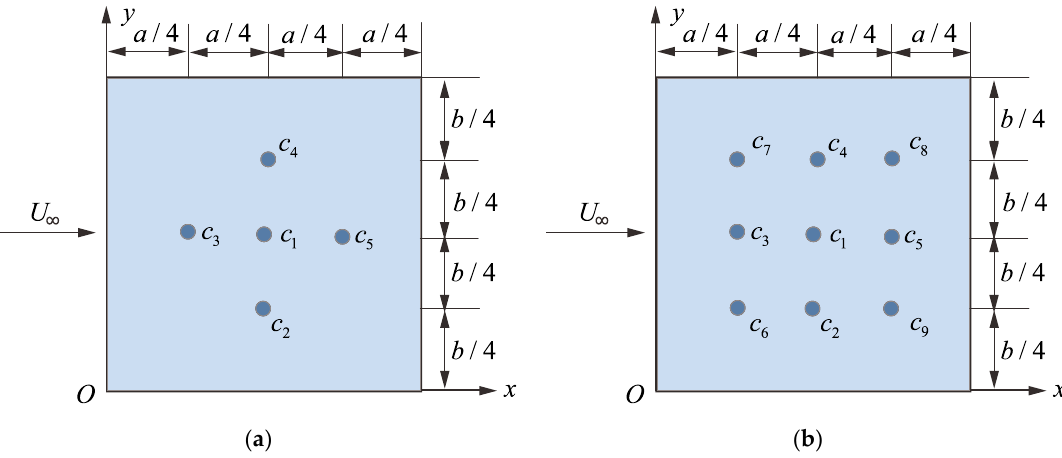
Figure 15. Two different damper configurations to suppress panel flutter with mass attachments: